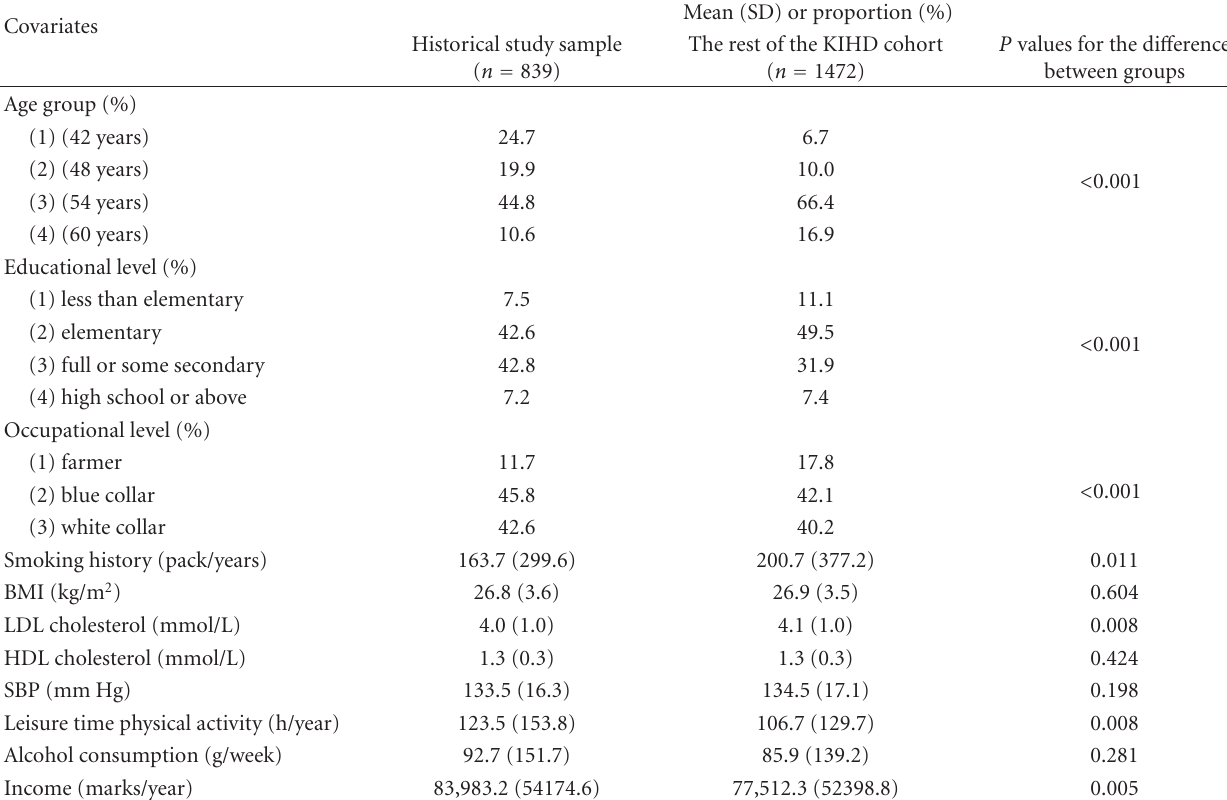
Table 1: Comparison of the historical study sample ( n = 839) with the rest of the Kuopio Ischaemic Risk Factor study (KIHD) cohort ( n =